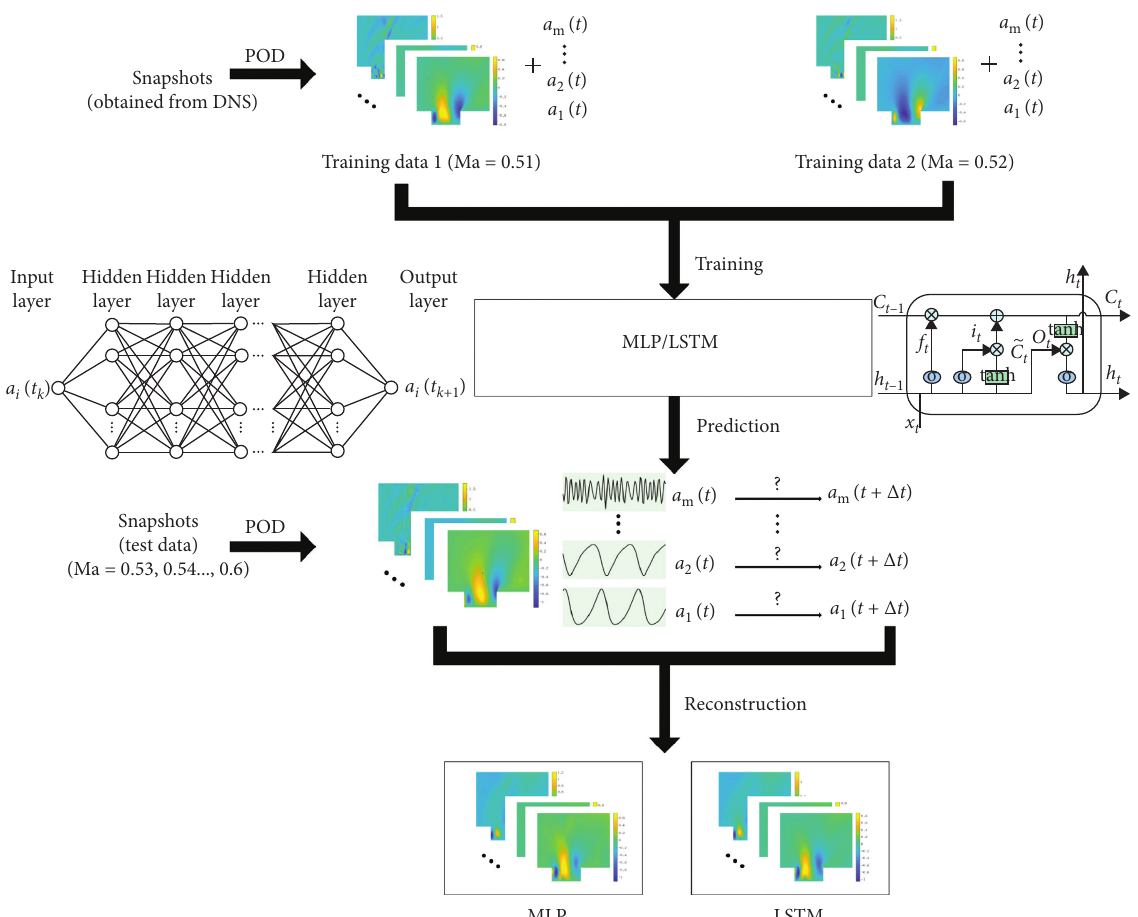
Figure 4: Flow chart of the reduced-order model using MLP or LSTM.